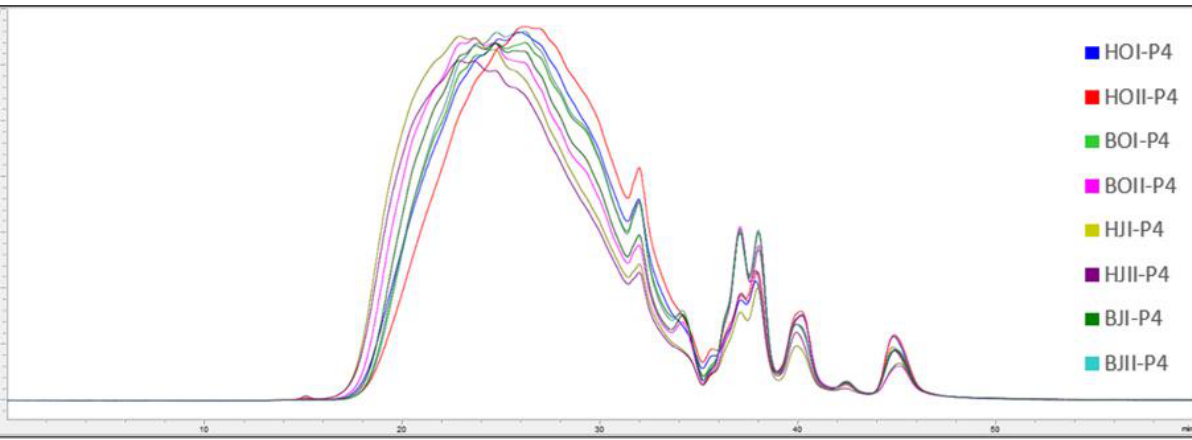
Figure 4. Chromatograms (mAU/min) from analysis of molecular weight distribution ( x ̅ ± SEM, n = 2) of permeates (P4) after ultrafiltration (<4 kDa) of saithe protein hydrolysates obtained from enzymatic hydrolysis of heads (H) and backbones (B), in two bioreactors (I, II), from saithe caught in October 2019 (HOI-P4 (blue), HOII-P4 (red), BOI-P4 (green), BOII-P4 (pink)) and January 2020 (HJI-P4 (beige), HJII-P4 (purple), BJI-P4 (dark green), BJII-P4 (turquoise)).